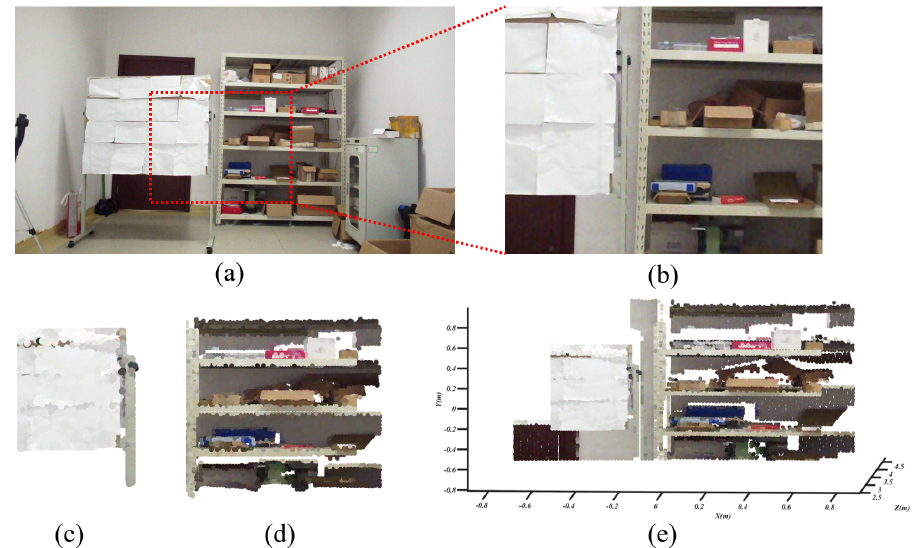
Figure 12. Fusion of LiDAR data and image data. ( a ) Experiment scene. ( b ) Area scanned by LiDAR. ( c ) Colorized point cloud of whiteboard. ( d ) Colorized point cloud of goods shelves. ( e ) Colorized point cloud in scene.